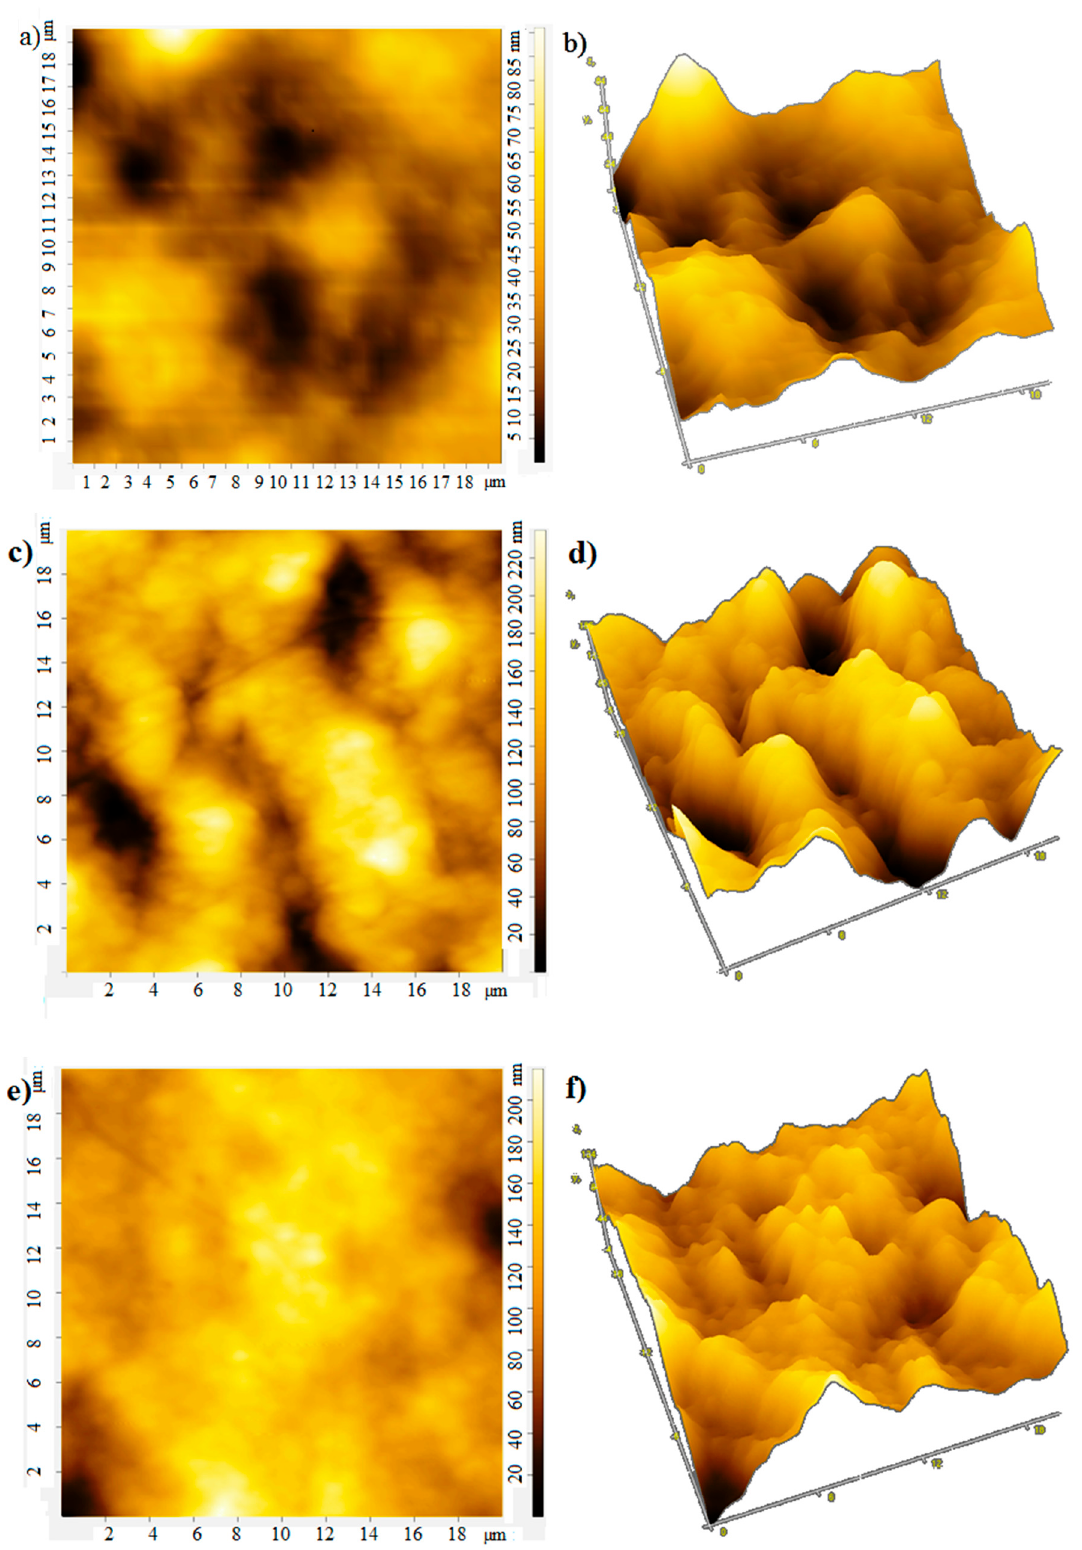
Figure 6. AFM: ( a ) 2D and ( b ) 3D image at rotation speed 700 rpm; ( c ) 2D and ( d ) 3D image at rotation speed 800 rpm; ( e ) 2D and ( f ) 3D image at rotation speed 900 rpm.